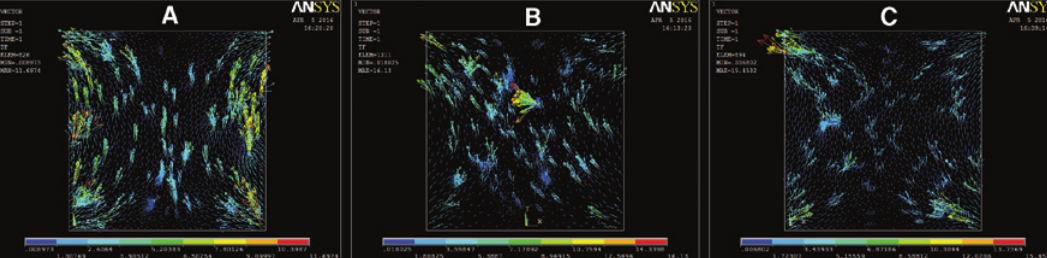
Figure 7: Vector diagrams of the thermal flux of vertical type (A), slant type (B), and parallel type (C) of fillers in composites.